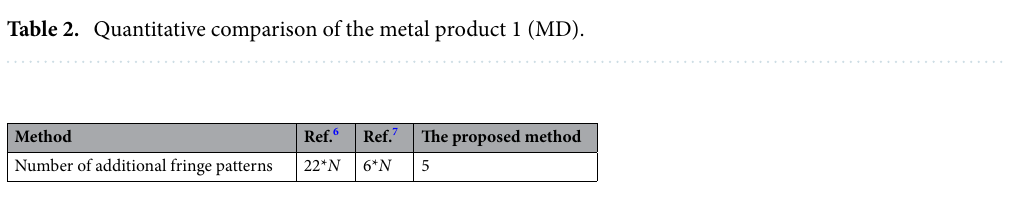
Table 3. Number of additional fringe